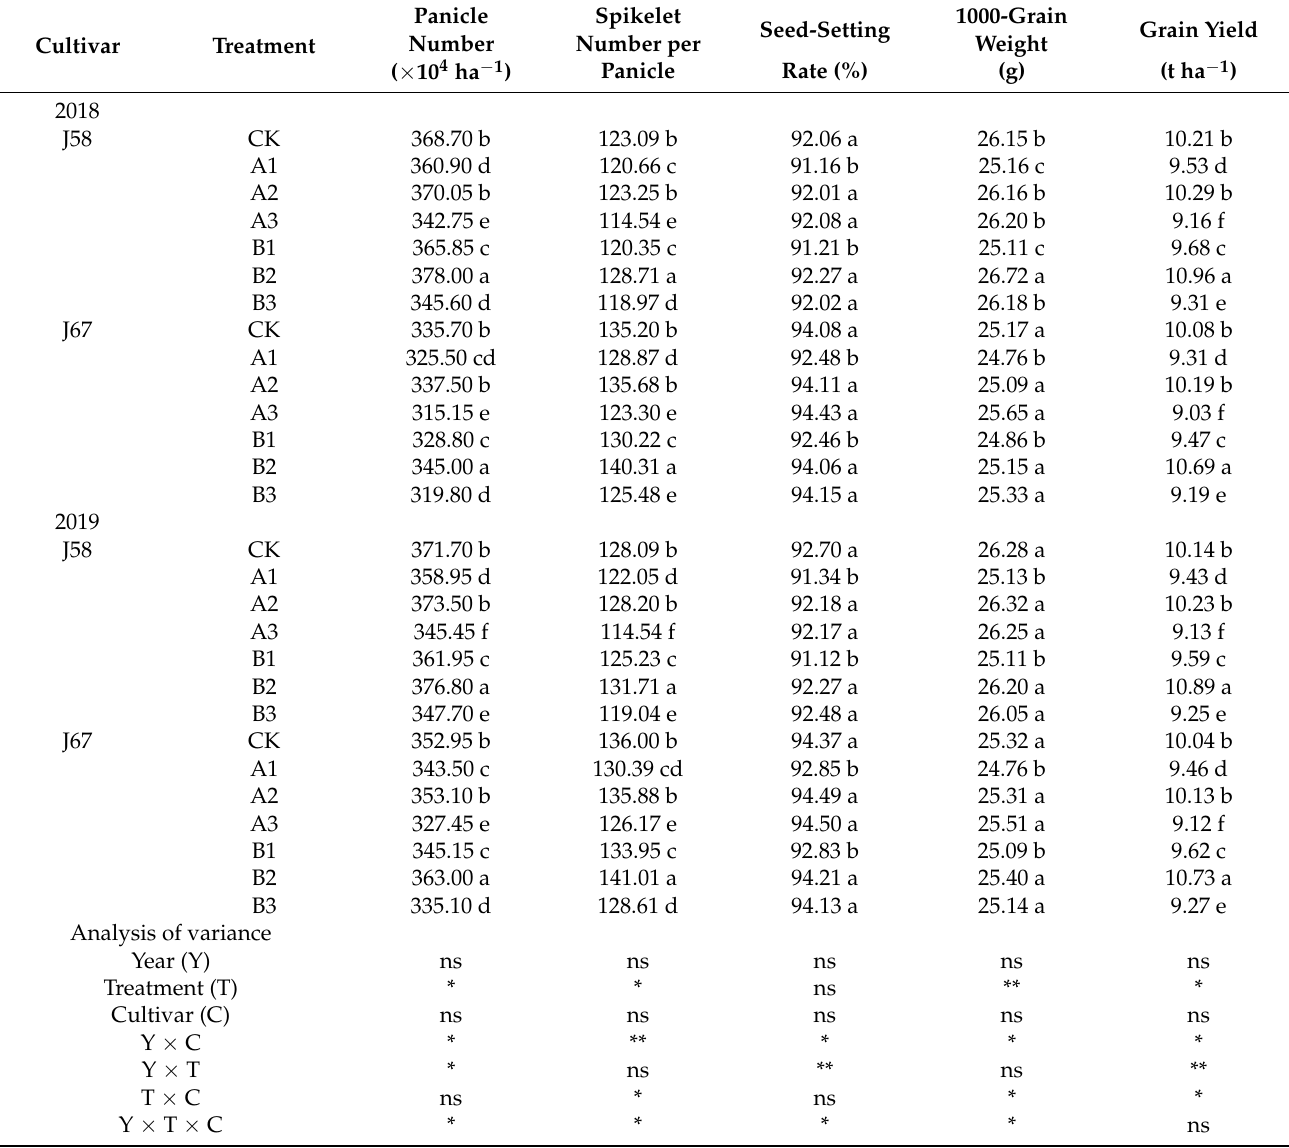
Table 2. Differences in yield and yield components of late japonica